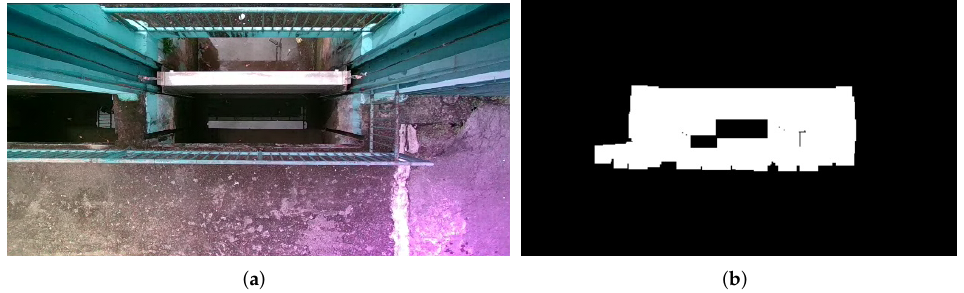
Figure 2. ( a ) Captured frame from camera experiencing chromatic aberration in bottom right of the scene. ( b ) Thresholded region which forms the basis for the ROI